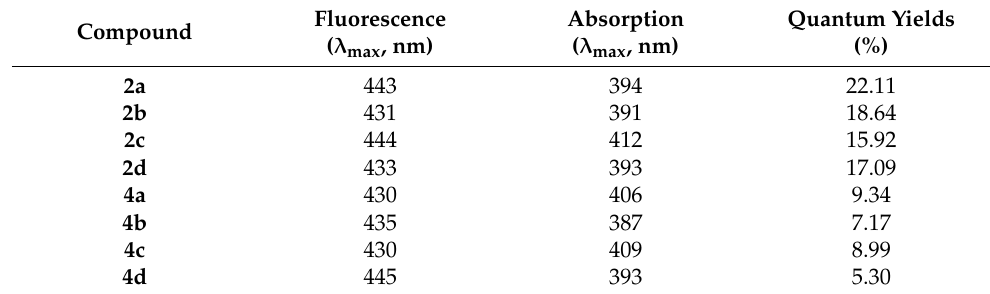
Figure 1. The absorption spectra recorded in chloroform solution of the functionalized derivatives: ( I ) bromides 2a – d and ( II ) azides 4a – d. Table 3. λ max (nm) of absorption spectra, λ max (nm) of emission spectra and fluorescence quantum yield (%) of compounds 2a – d and 4a – d .